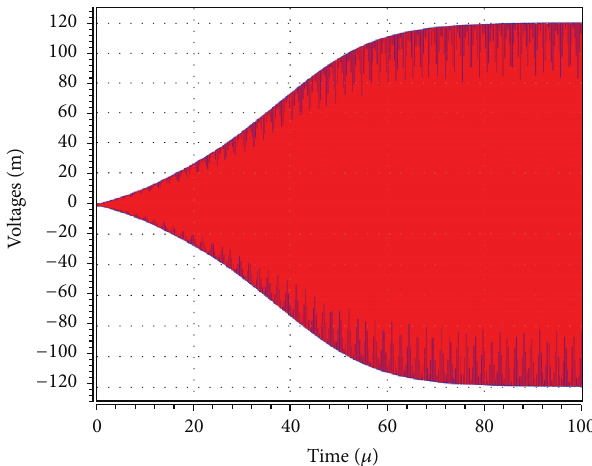
Figure 7: Simulated quadrature voltage output waves of 𝑉 𝑜1 (blue) and 𝑉 𝑜2 (red).